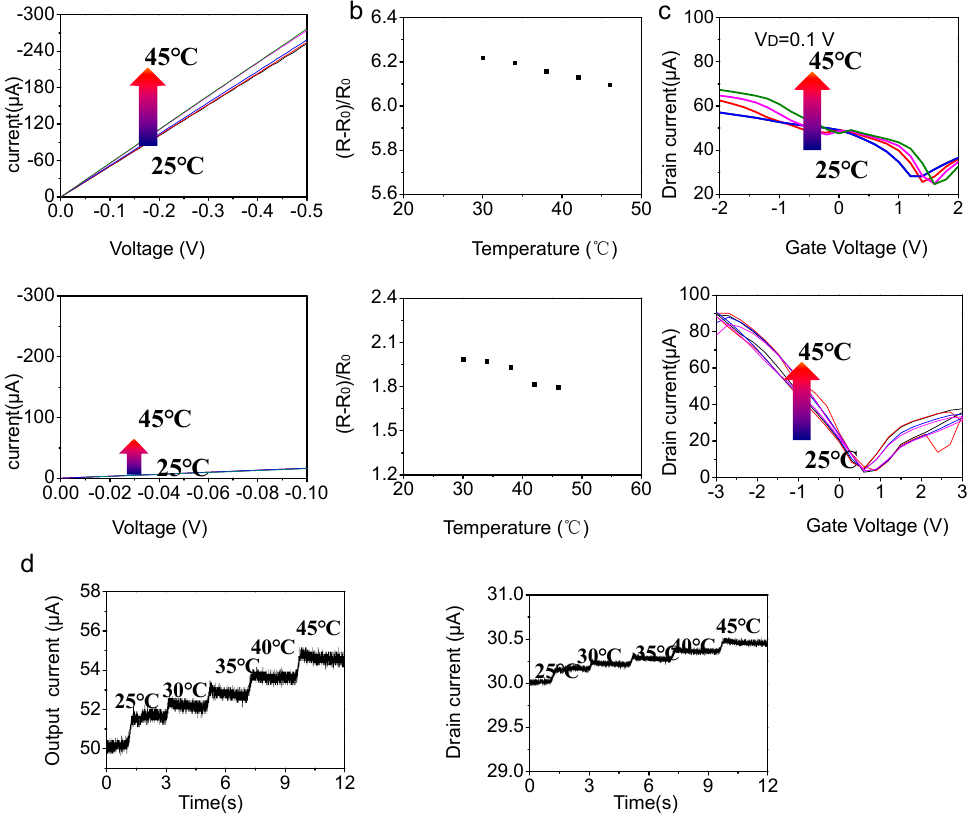
Figure 3. ( a ) The IV character of trilayer graphene scrolls ( top panel) and monolayer graphene ( bottom panel) (graphene films transferred on Ecoflex were patterned into 500 μ m-wide and 2000 μ m-long channels by photolithography). ( b )The extracted relative resistance variation ( R − R 0 )/ R 0 of trilayer graphene scrolls ( top panel) and monolayer graphene ( bottom panel). ( c ) Transfer characteristic of GSFET ( top panel) and GFET ( bottom panel) under varied temperature. ( d ) The real-time temperature monitoring of GFET ( right panel) and GSFET ( left panel) .